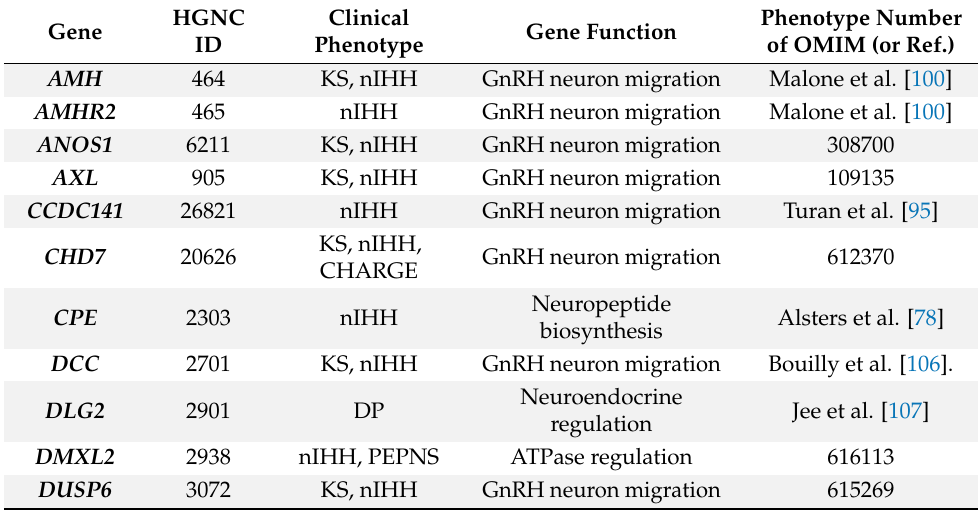
Table 1. Genetic causes of idiopathic hypogonadotropic